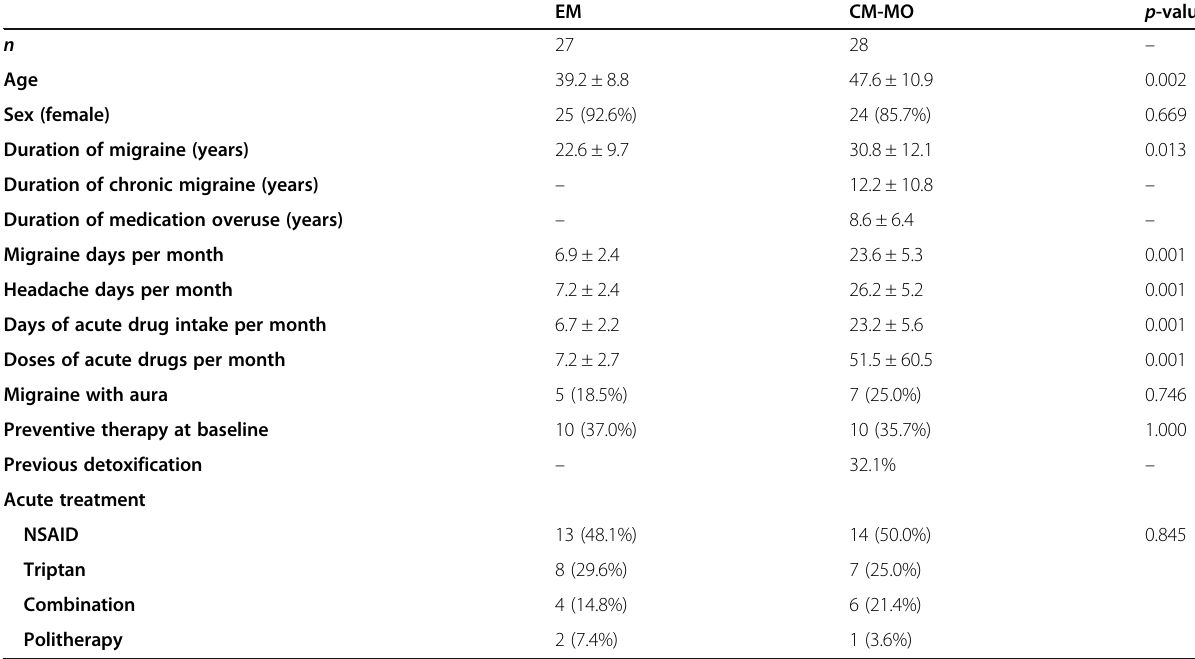
Table 1 Clinical and demographic features of study population at